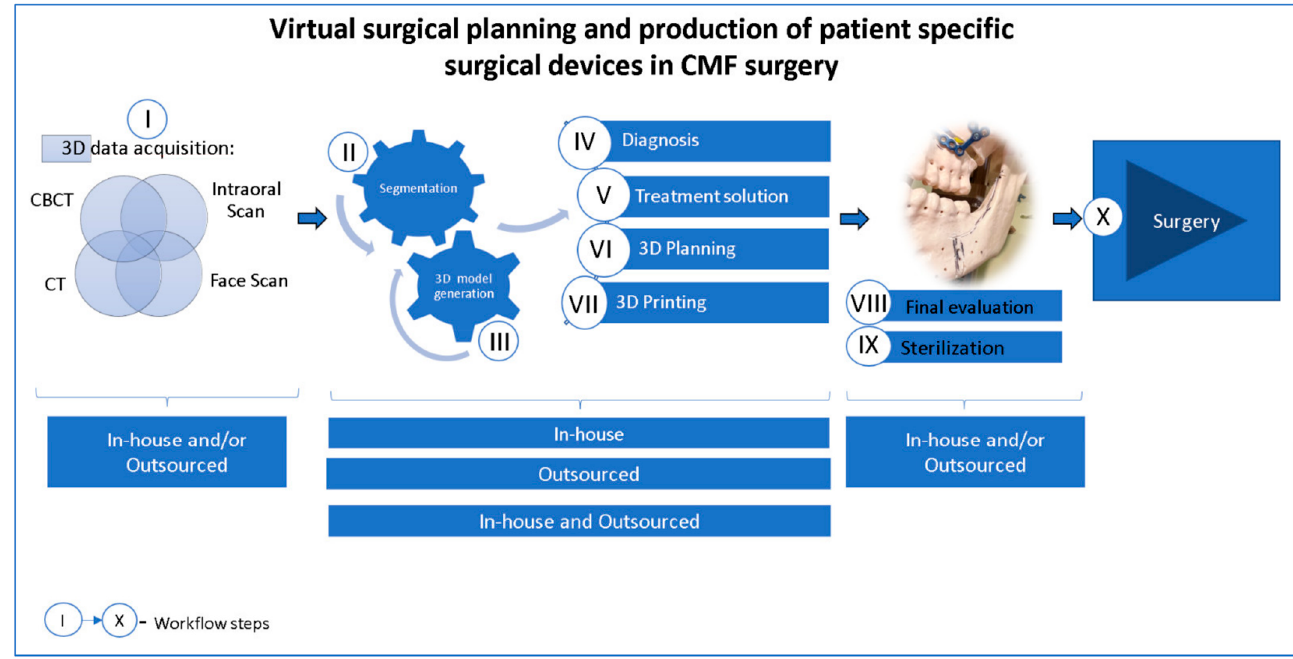
Figure 5. Manufacturing workflow for patient-specific surgical devices in CMF surgery.